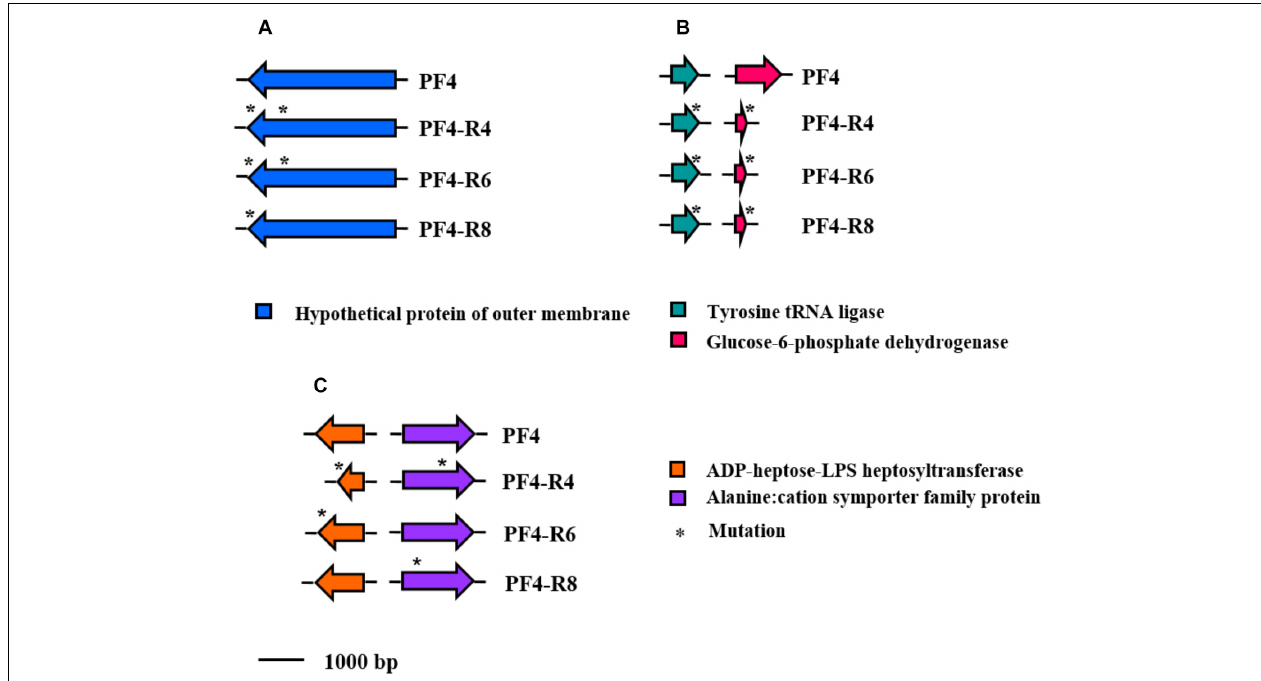
FIGURE 7 | Schematic representation of the distribution of specific mutations in phage-resistant strains of V. anguillarum . Genes are represented as arrows and point mutations are represented as asterisks. Functions for genes are shown in colored boxes. (A) Mutation shared by all phage-resistant strains on the chromosome I (accession number WP_017049502.1); (B) Mutation shared by all phage-resistant strains on the chromosome II (accession numbers NP_230280.1 and NP_233281.1, respectively). (C) Mutation shared by two of the phage-resistant strains (accession numbers WP_019281202.1 and NP_797001.1, respectively).